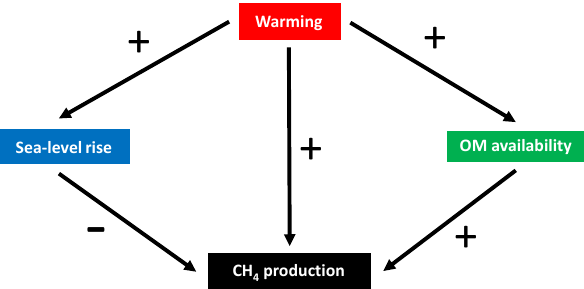
Figure 1. Conceptual diagram illustrating the potential effects of warming, sea-level rise, and increased organic matter (OM) avail- ability on CH 4 production in coastal wetlands. These three global change mechanisms are all indirect consequences of rising CO 2 lev-